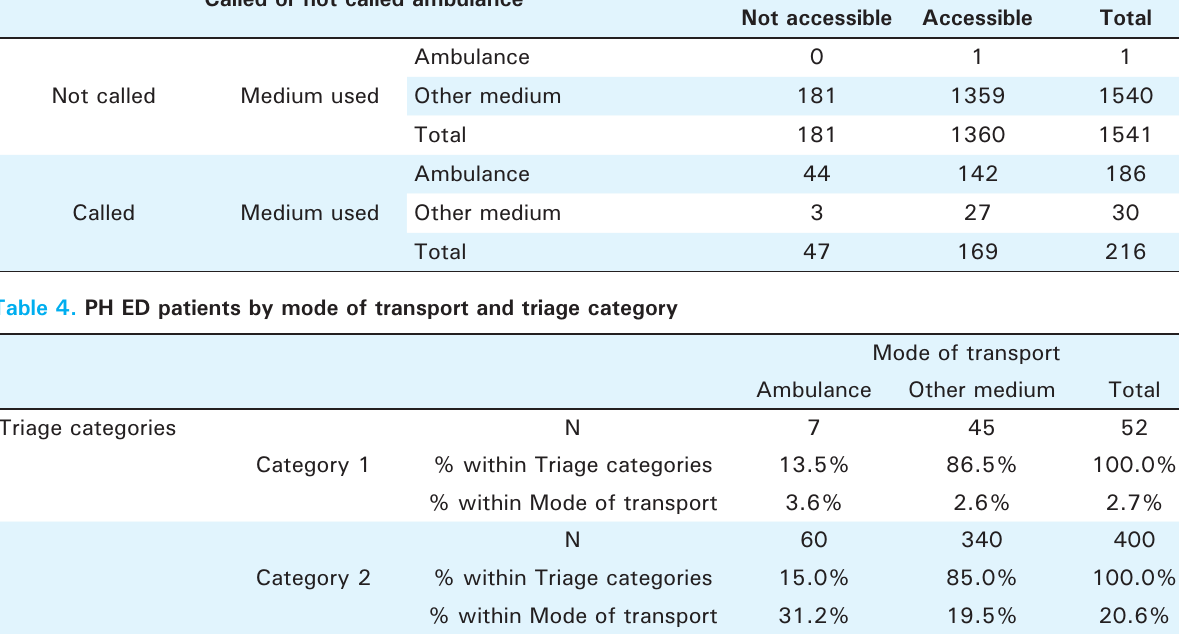
Accessible or Not accessible